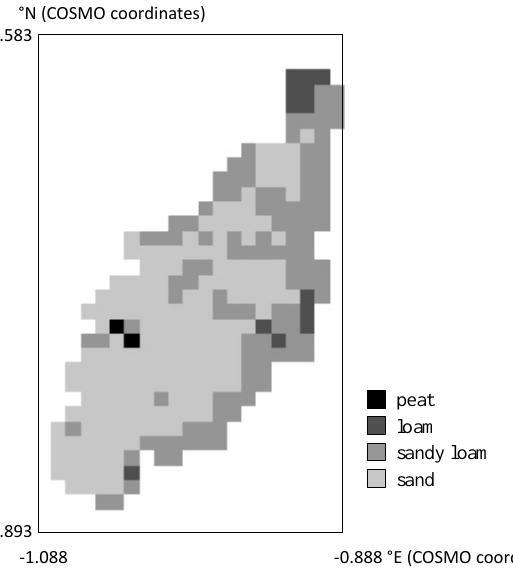
Fig. 3. Soil texture based on 1:200000 soil map (B ¨UK 200) of the LGRB (Landesamt f¨ur Geologie, Rohstoffe und Bergbau) (Warrach-Sagi et al., 2008). In TERRA-ML the saturated soil mois- ture is 0.364m/m for sand, 0.445m/m for sandy loam, 0.463m/m for loam and 0.863m/m for